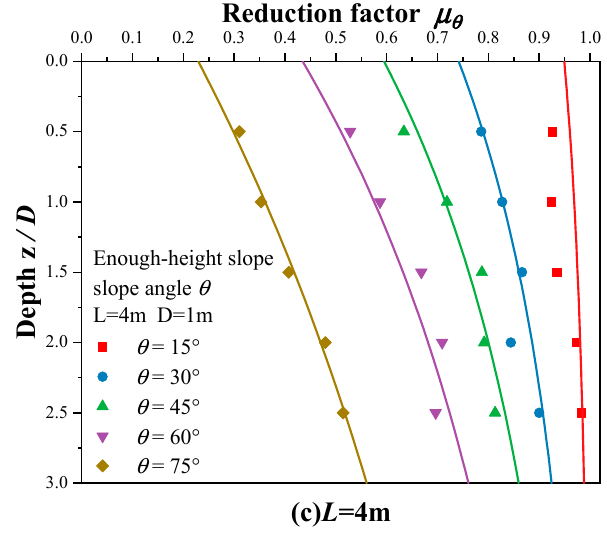
Figure 3. Effect of 𝜃 on 𝜇 (cid:2968) by FEA for ( a ) L = 20 m; ( b ) L = 12 m; ( c ) L = 4 m.